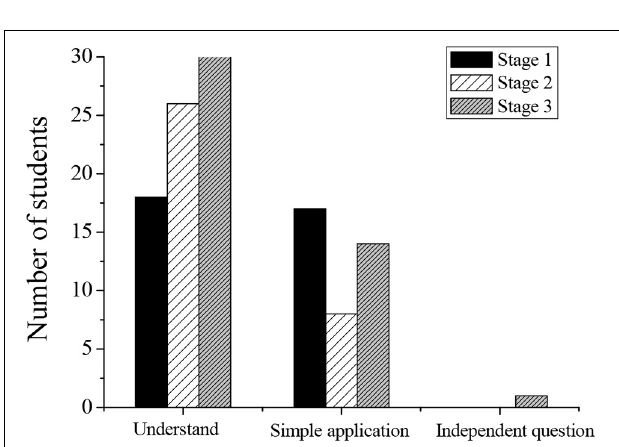
FIGURE 5 | Deep cognition of the three-stage text tasks of